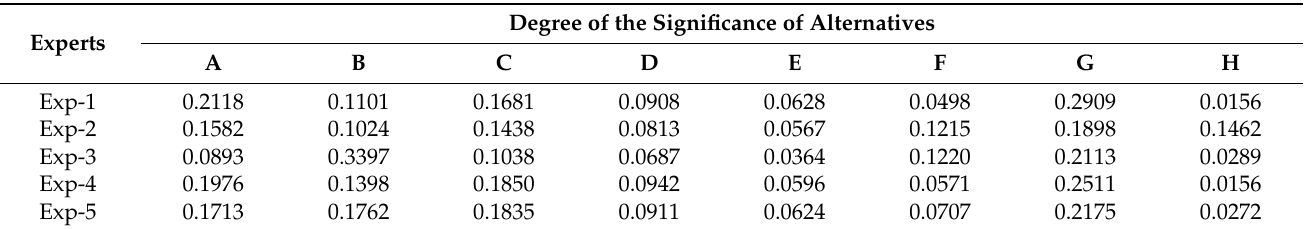
Table 10. Importance value of each alternative from the perspective of each expert.